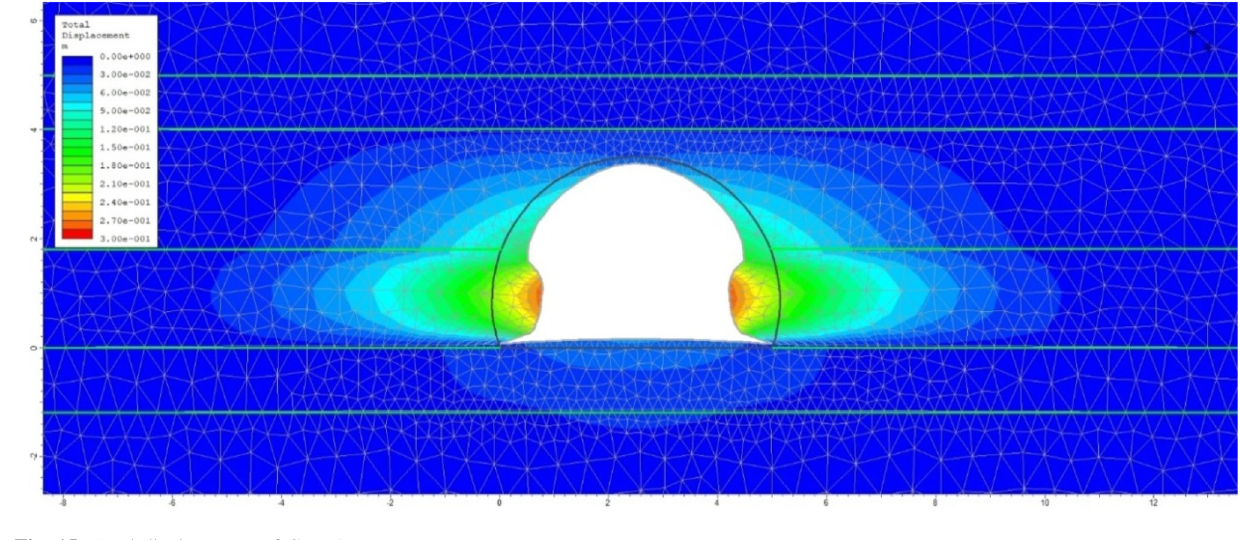
Fig. 15 Total displacement of Case 1